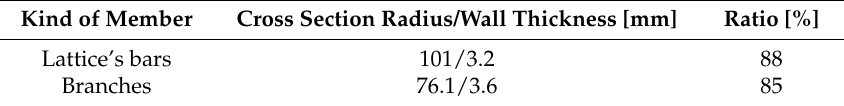
Table 5. Dimensioning of the considered roof structure due to structural